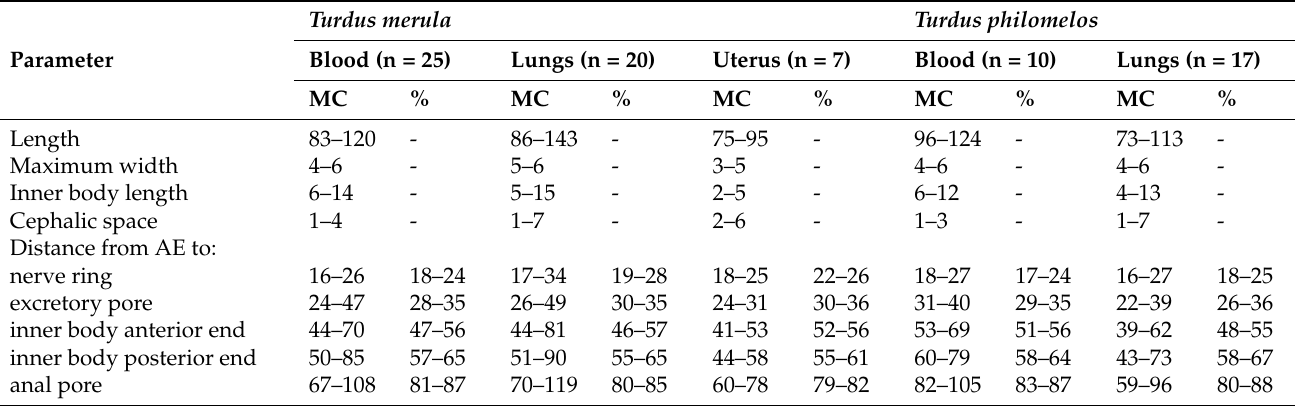
Table 3. Measurements of Splendidofilaria mavis microfilariae from the blood, lungs, and uterus form the Eurasian blackbird ( Turdus merula ) and the Song thrush ( Turdus philomelos ).